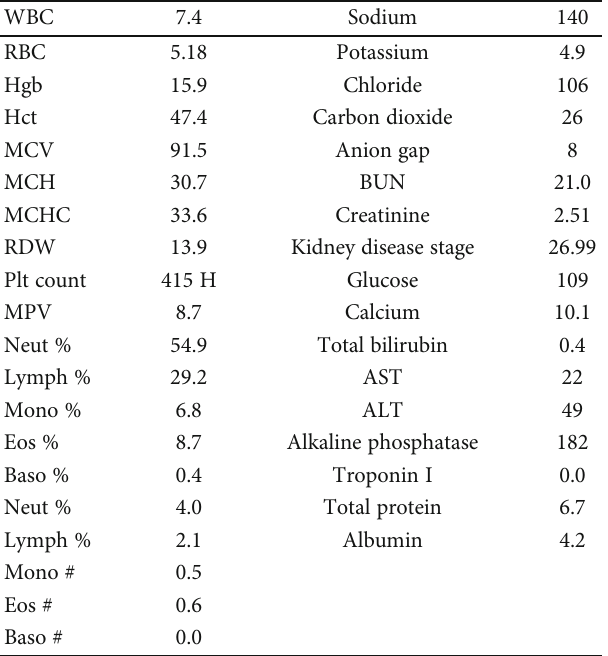
Table 1: A complete blood count and comprehensive metabolic